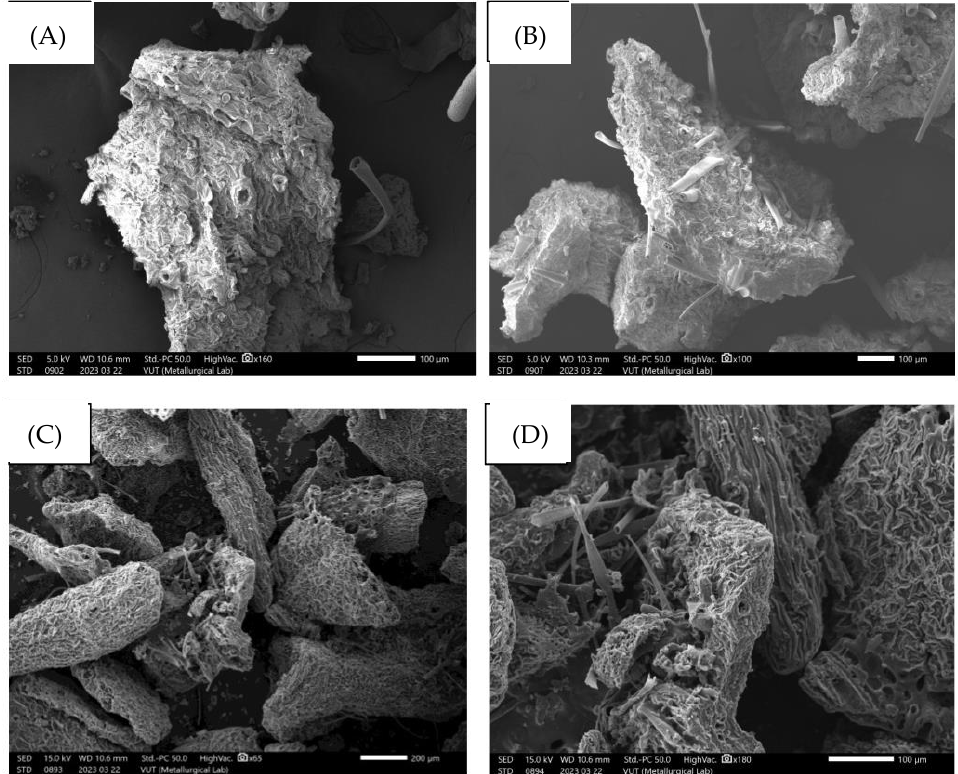
Figure 12. After adsorption, SEM images of Raw-RGL ( A , B ) and AC-RGL ( C , D ).